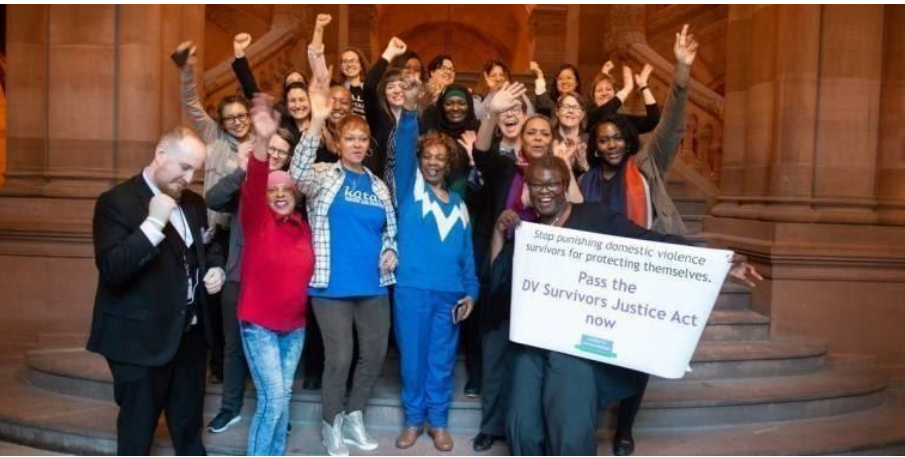
Figure 1. Lobbying for passage of the DV Survivors Justice Act (Photo by Nasir Abdul-Mumin). Both Anisah Sabur-Mumin and Sharon White-Harrigan were instrumental in the de- velopment and passage of the